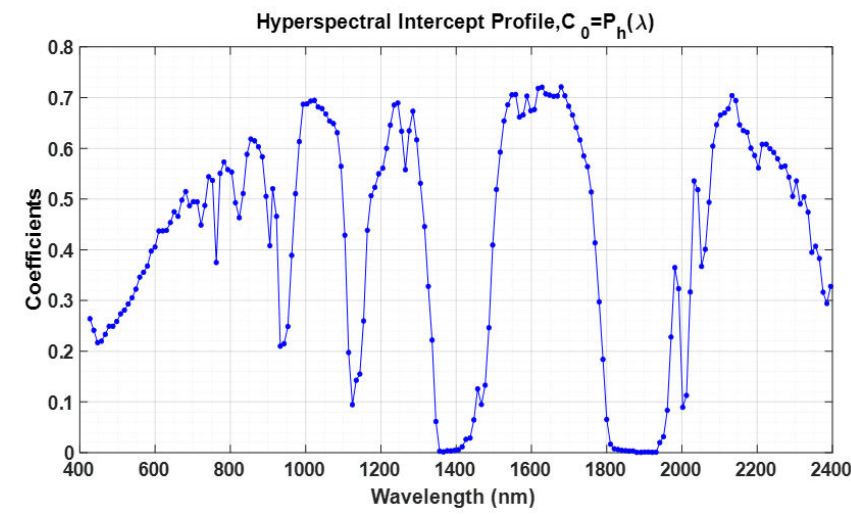
Figure 7. Intercept, C 0 ( λ )